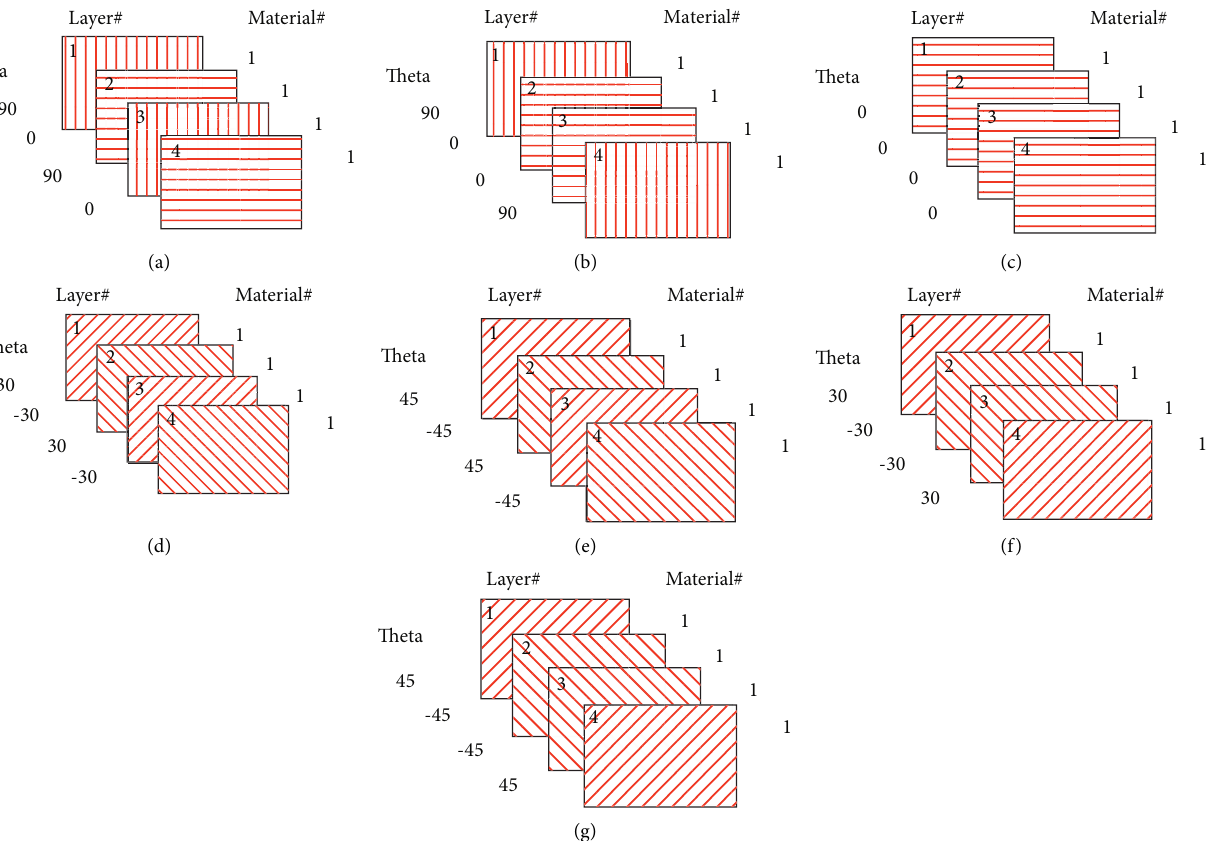
Figure 2: Illustration of the laminate ply arrangement: (a) antisymmetric cross-ply, (b) symmetric cross-ply, (c) unidirectional, (d) antisymmetric 30, (e) antisymmetric 45, (f) symmetric 30, and (g) symmetric